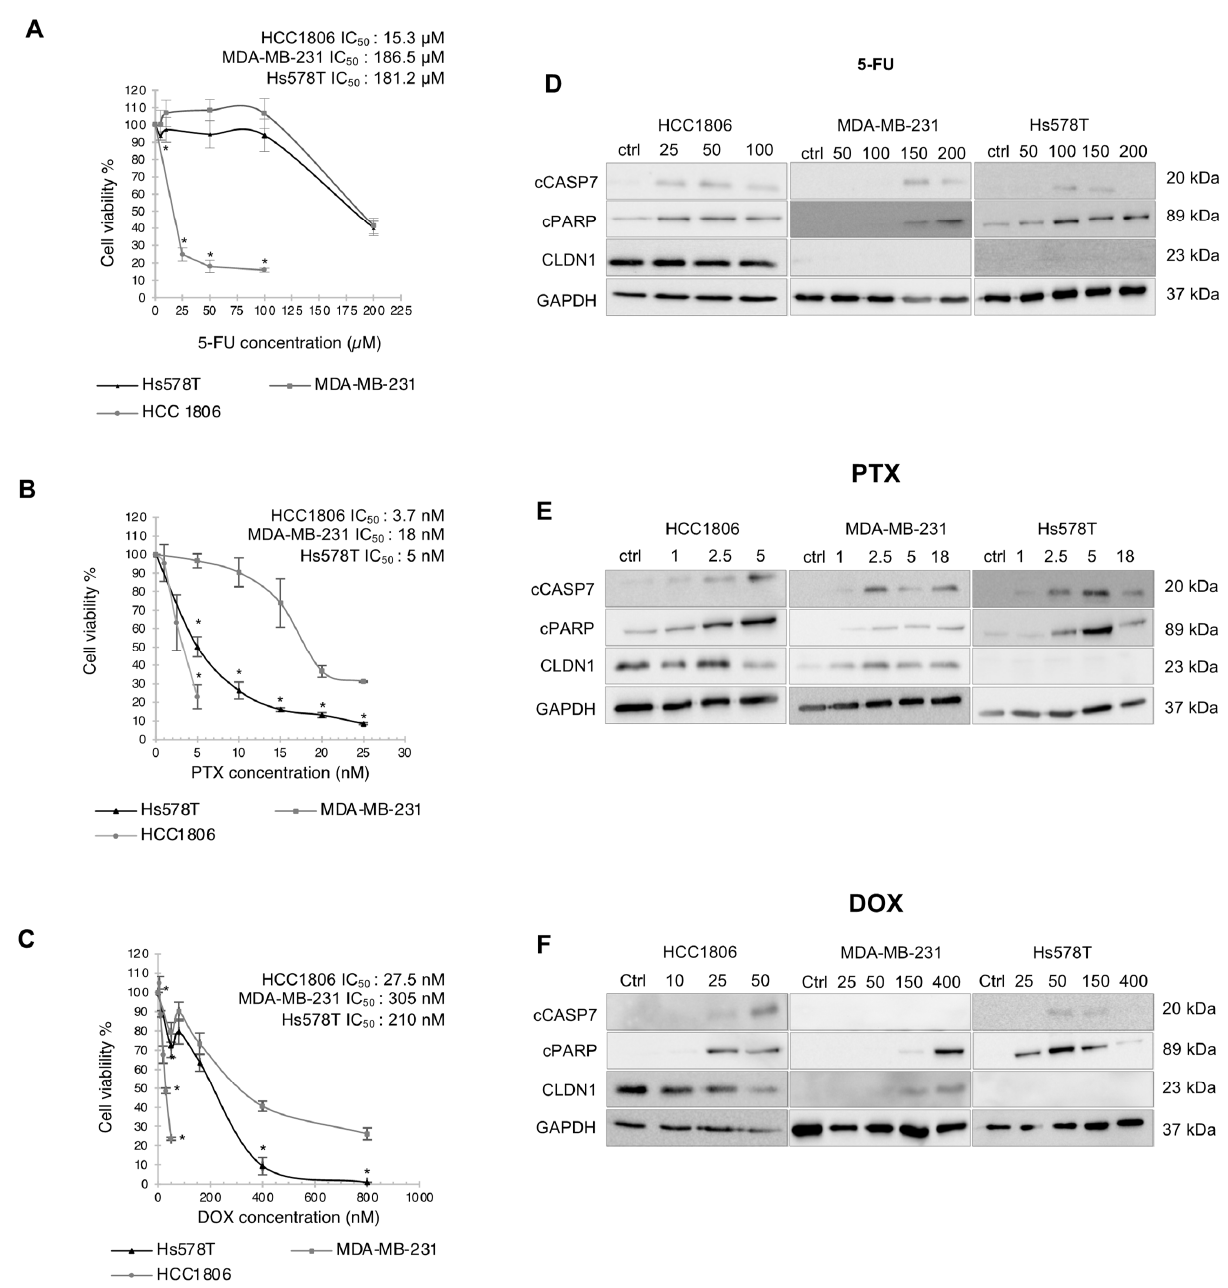
Figure 2. “Claudin-1-high” TNBC cells are more sensitive than “claudin-1-low” TNBC cells to chemotherapy. HCC1806, MDA-MB-231 and Hs578T cells were treated for 72 h with increasing doses of ( A ) 5-FU (0, 5, 10, 25, 50, 100, 200 µM), ( B ) PTX (0, 1, 2.5, 5, 10, 15, 20, 25 nM) and ( C ) DOX (0, 5, 10, 20, 30, 50, 160, 400, 800 nM). Cell viability was determined by measuring ATP level. The results are expressed as a percentage of the control cells exposed to the solvent and IC50s are specified above the graphs. Cells were treated for 72 h at different concentrations of ( D ) 5-FU (0, 25, 50, 100, 150, 200 µM); ( E ) PTX (0, 1, 2.5, 5, 18 nM); and ( F ) DOX (0, 10, 25, 50, 150, 400 nM). Analysis of CLDN1, cleaved apoptotic markers PARP-1 (cPARP) and caspase 7 (cCASP7) expression was performed by western blot. The GAPDH was used as an internal reference. Western Blots expression are representative of 3 to 4 independent experiments. The values represent the means ± SEM of three to four different experiments. A p -value of less than 0.05 was considered statistically significant with * p < 0.05. The uncropped blots are shown in File